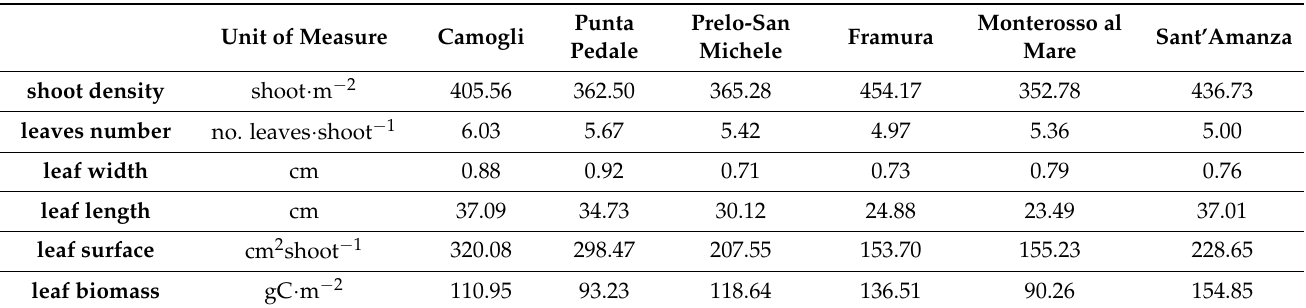
Table 2. Results for the leaves of Posidonia oceanica meadows obtained through field surveys and laboratory analysis Values are expressed as the average between the two stations of each meadow.